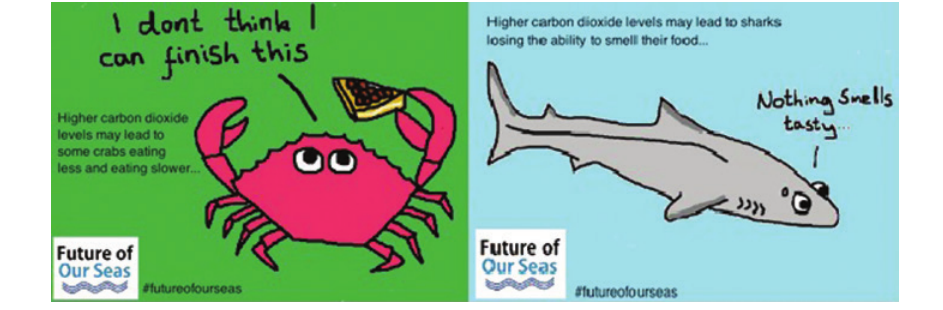
figure 2: example of using creativity to communicate a challenging topic during the plastics and acid activity (see activity 7, below) (credit: charlie